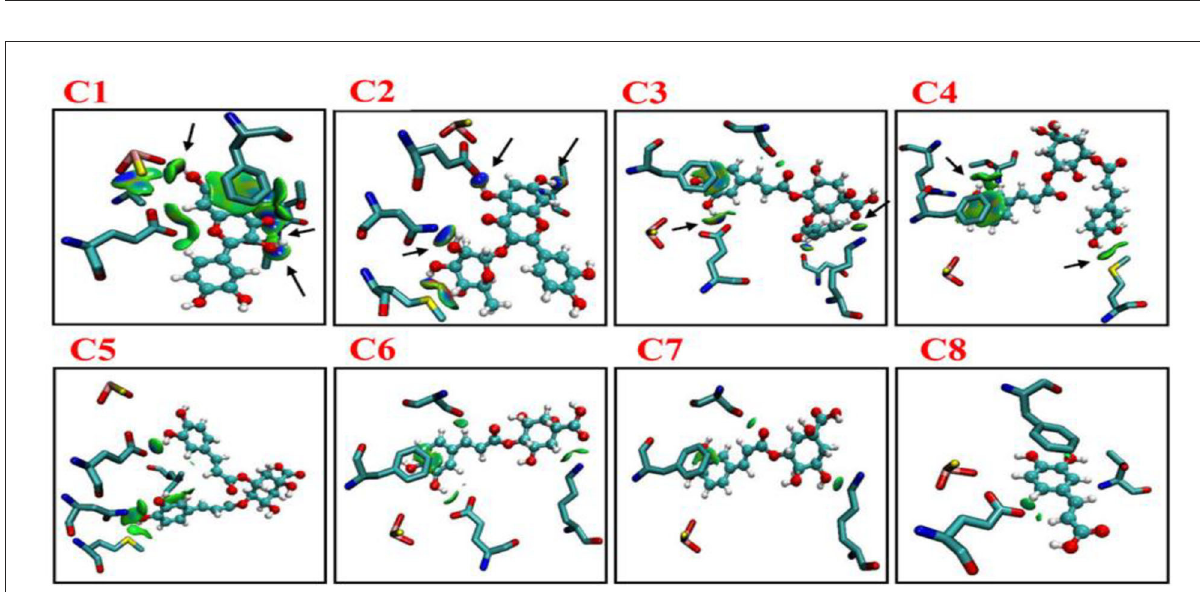
FIGURE7 Intermolecular interactions (isosurfaces: 0.01a.u.) for different models using IGM analysis (blue represents a strong attraction, and green denotes a weak repulsion). C1, quercetin; C2, quercetin-3-rhamnoside; C3, 4,5-O-dicaffeoylquinic acid; C4, 3,5-O-dicaffeoylquinic acid; C5, 3,4-O-di-caffeoylquinic acid; C6, 4-O-caffeoylquinic acid; C7, 3-O-caffeoylquinic acid; and C8, caffeic acid.